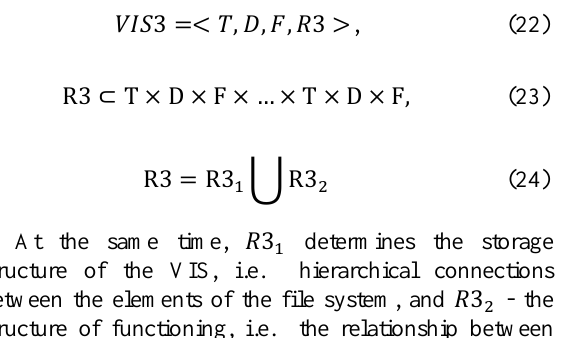
Fig. 1. Representation of the VIS implementation model